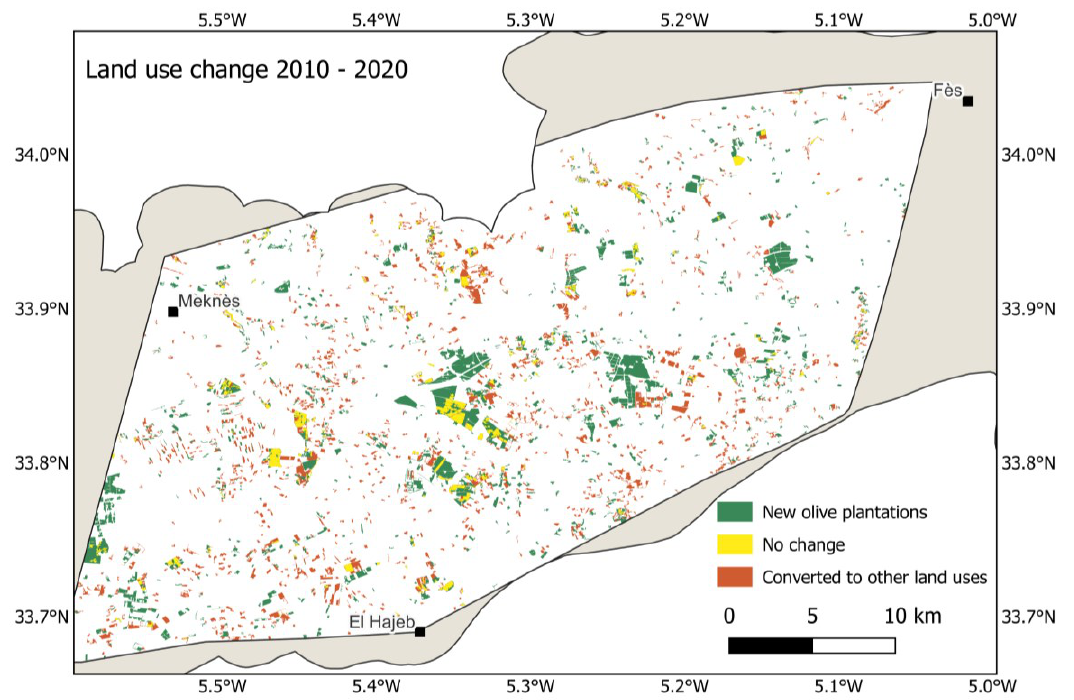
Figure 13. Land-use change of detected olive plantations between 2010 and 2020.